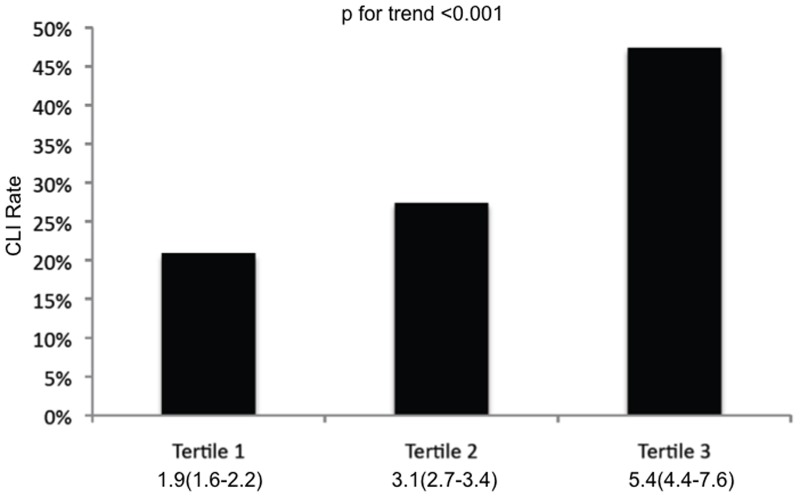
Percentage of patients with CLI stratified by tertile of NLR.Numbers below the figure are median NLR and the 25th and 75th percentile.